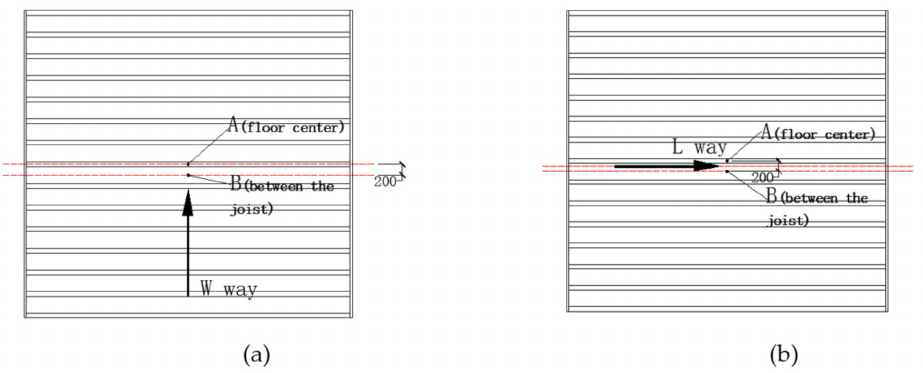
Figure 18. Walking direction and path: ( a ) perpendicular to the joist direction (W path); ( b ) parallel to the joist direction (L path).